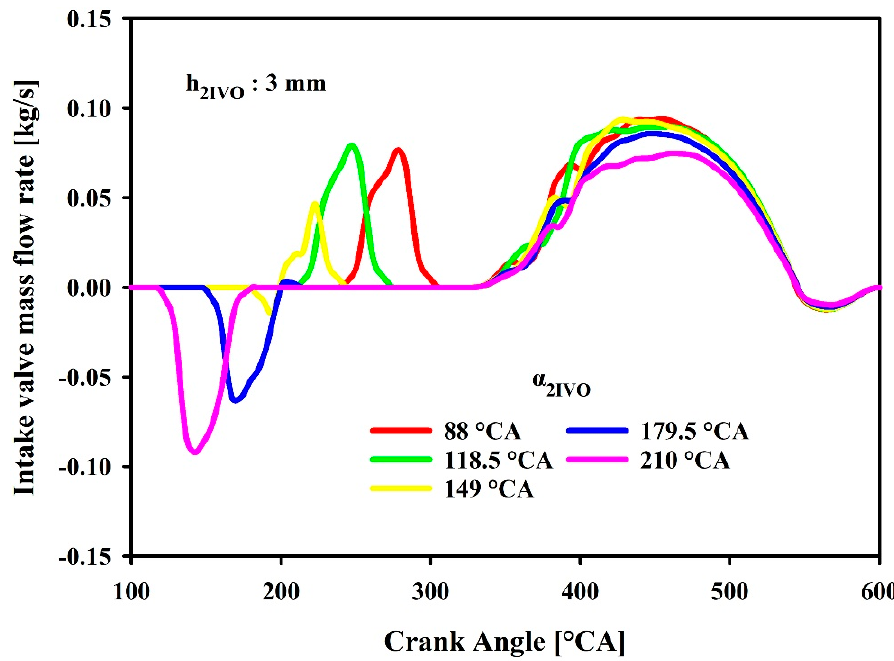
Figure 5. Mass flow rate across the intake valve for varying α 2IVO .